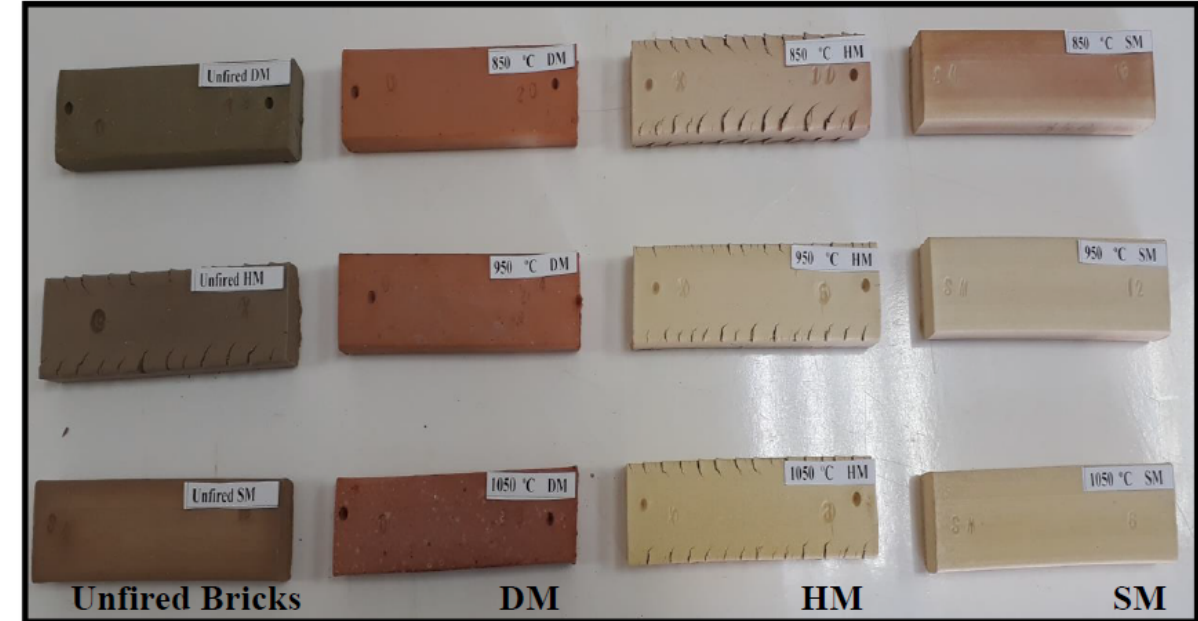
Figure 7. The digital images of unfired DM, HM, and SM brick specimens, and DM, HM, and SM fired at 850 °C, 950 °C, and 1050 °C.